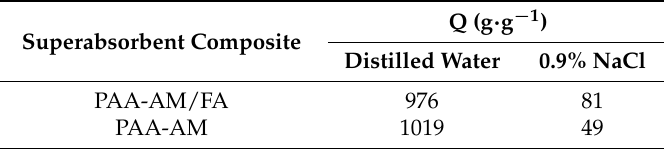
Table 1. The absorbency of superabsorbent poly (acrylic acid-acrylamide/fly ash) (PAA-AM/FA) composite and PAA-AM.